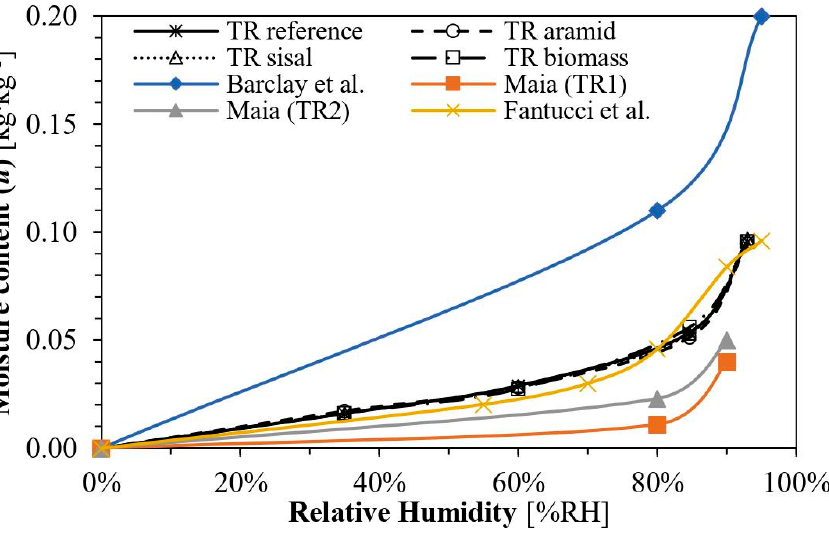
Figure 5. Sorption isotherms for the renders (black) at 23 °C, compared with other results [11,33,62]. In the same Figure 5, it is also seen that all aerogel-containing formulations (the ones herein studied and the one presented by Fantucci et al. [11]) show similar hygroscopic behaviour; therefore, it seems that the fibres did not significantly influence the hygroscopic behaviour already shown by the reference (TR reference) and other similar products. When compared with the thermal renders studied by Maia et al. [62], these aerogel-based thermal renders showed a higher degree of moisture uptake, but much lower than the